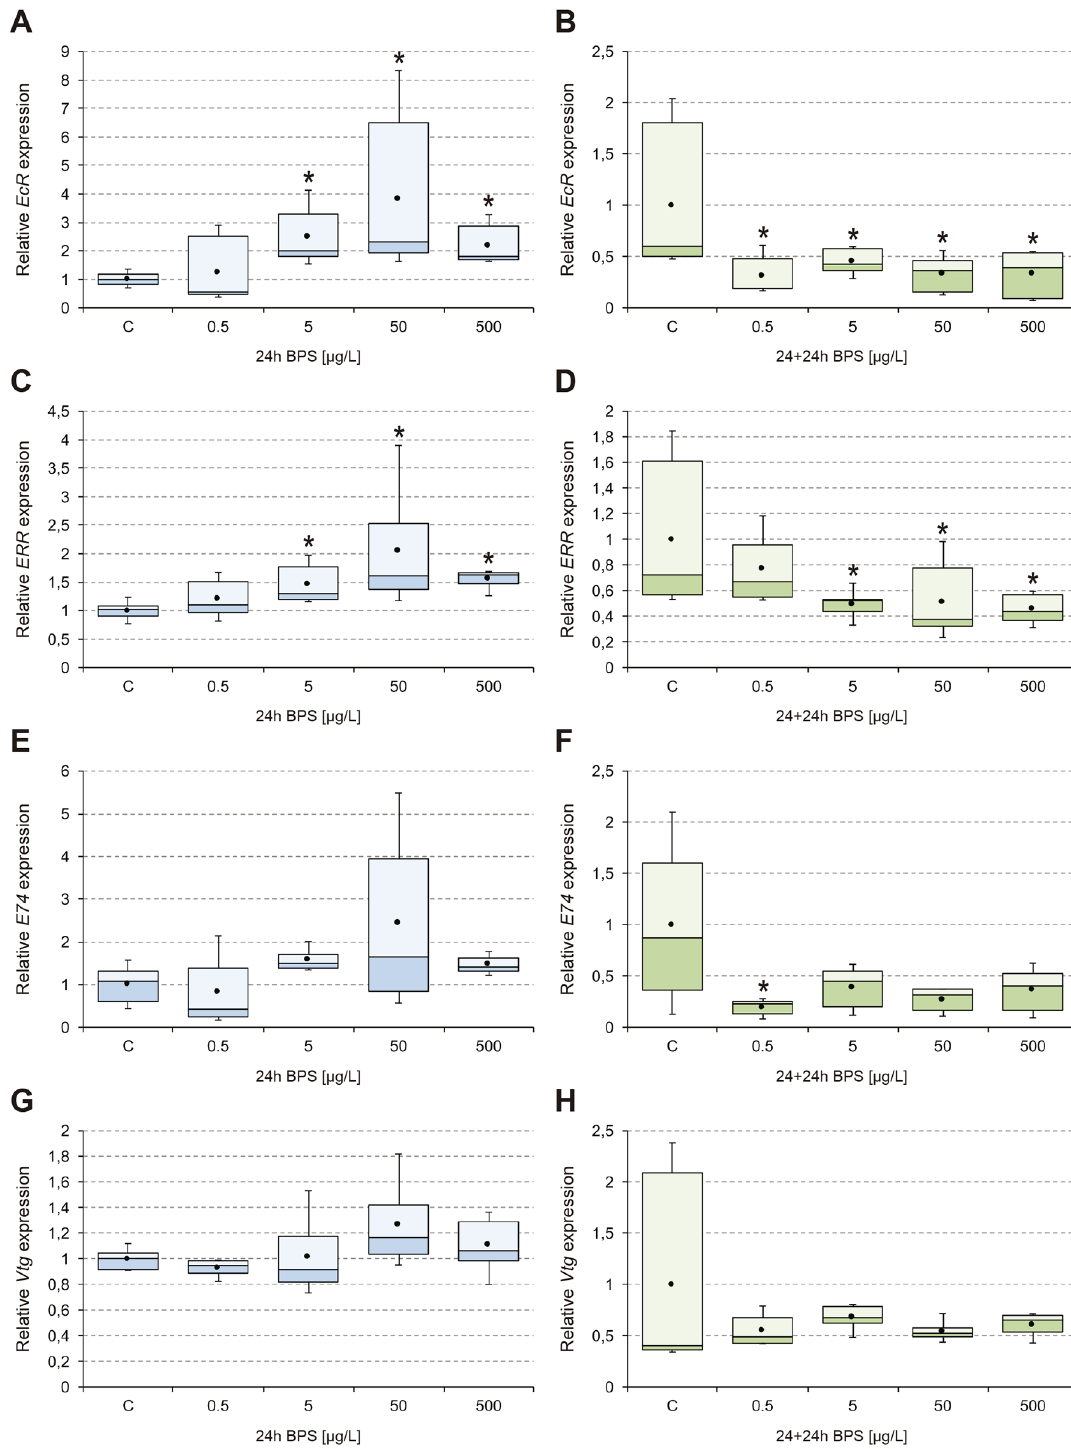
Fig 1. Transcriptional activity of EcR , ERR , E74 ,and Vtg . Box-and-whisker plots represent the expression patterns of EcR (A-B), ERR (C-D), E74 (E-F), and Vtg (G-H), measured by real-time RT-PCR. C . riparius fourth instar larvae were exposed to 0.5–500 μg/L BPS for 24 h (24h; left column; blue series), and maintained for an additional 24 h in fresh culture medium after BPS withdrawal (24+24h; right column; green series). Four independent experiments were performed and RNA was extracted from 5 larvae for each experimental condition (n = 20). Results were normalized to control values. Box and whiskers represent the 25–75 percentile and the